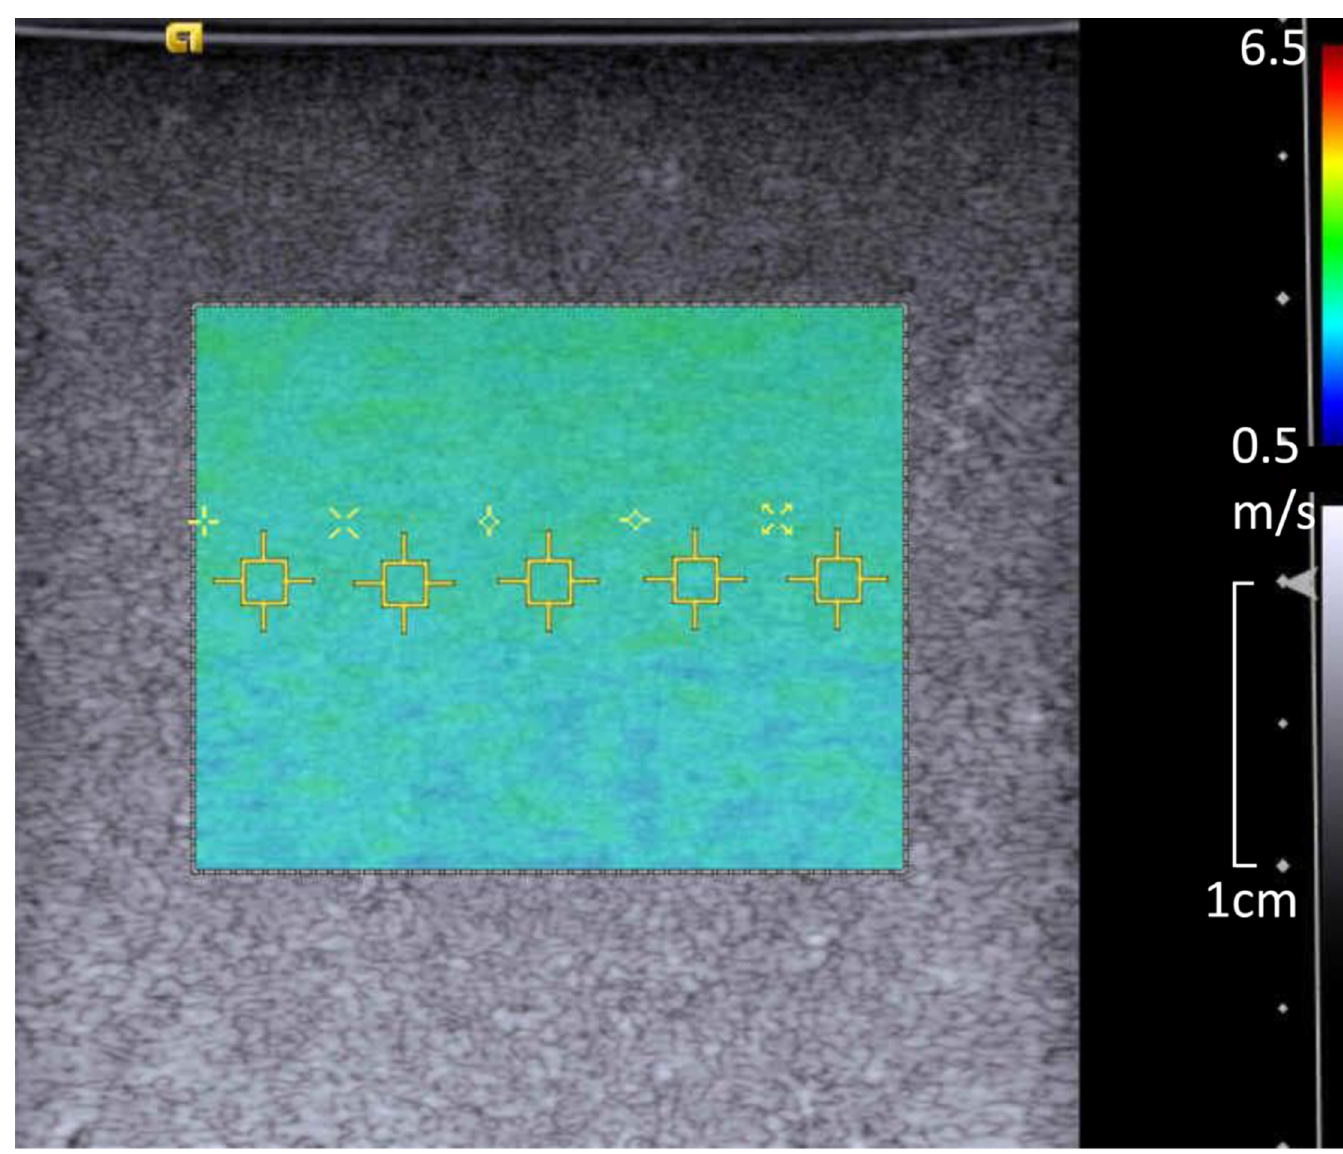
Fig 2. 2D color-coded shear wave elastography (2D SWE) image. The color box corresponds to the 2D-SWS distribution and the small yellow squares indicate ROIs for SWS measurement. Five ROIs were placed at a depth of 20 mm.